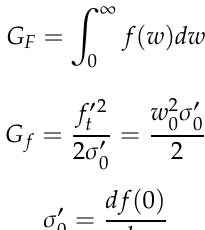
Figure 4. Difference between